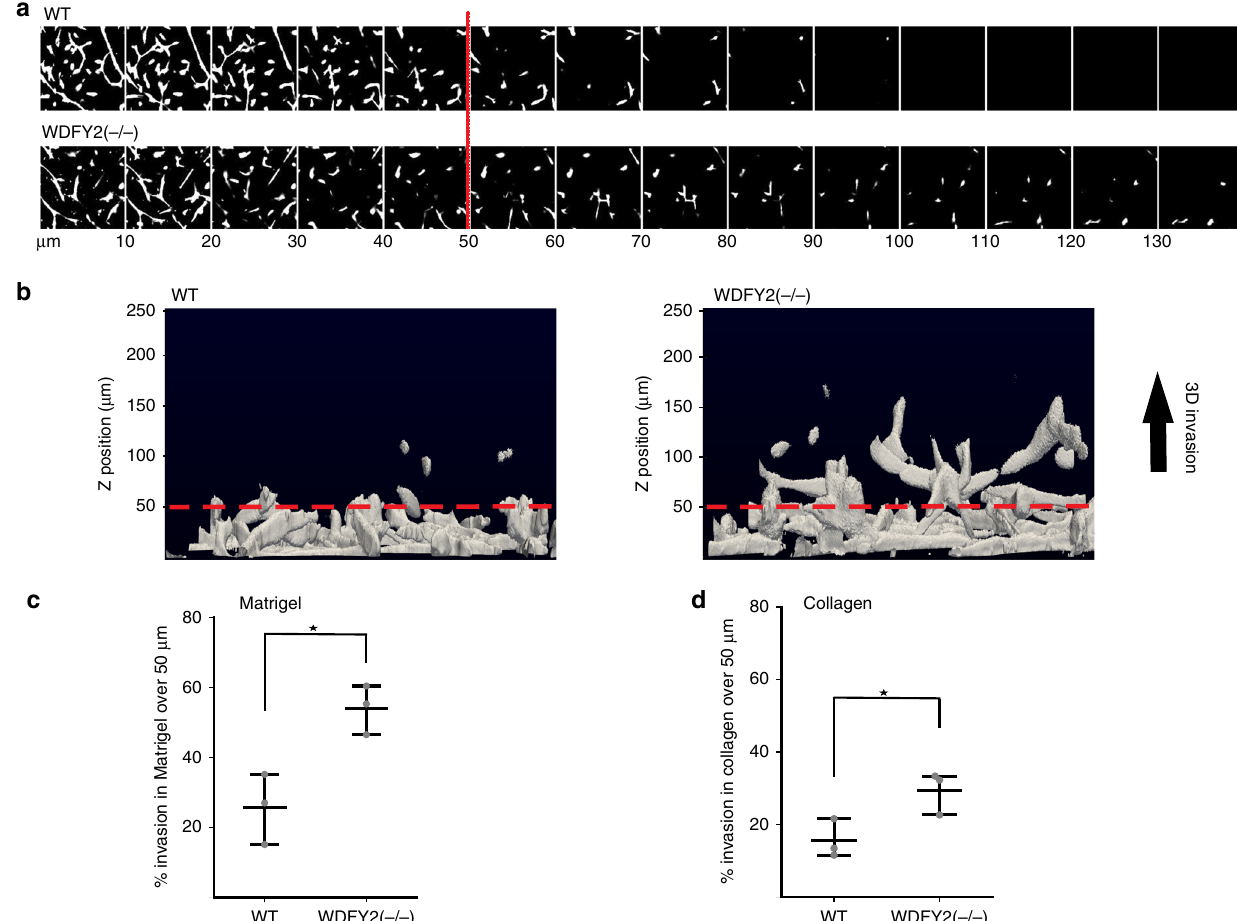
Fig. 8 WDFY2 controls invasive cell migration. a Optical sections ( Δ z = 10 µ m) of WT and WDFY2( − / − ) cells stained with Calcein-AM invading into fi bronectin-supplemented Matrigel TM . The red line indicates the z-axis threshold (50 µ m) de fi ning invading cells. b Orthogonal view of a 3D reconstruction of WT and WDFY2( − / − ) invading into fi bronectin-supplemented Matrigel TM . The red line indicates the z -axis threshold (50 µ m) de fi ning invading cells. c Quanti fi cation of invasion of WT and WDFY2( − / − ) cells into fi bronectin-supplemented Matrigel TM . Plotted points indicate the mean invasion per experiments (15 z -stacks per experiment, n = 3 experiments), also shown is the mean ± 95% CI. Student ’ s unpaired t test, p = 0.0162. * p < 0.05, ** p < 0.01, *** p < 0.001, n.s. not statistically signi fi cant. d Quanti fi cation of invasion of WT and WDFY2( − / − ) cells into fi bronectin-supplemented acid extracted